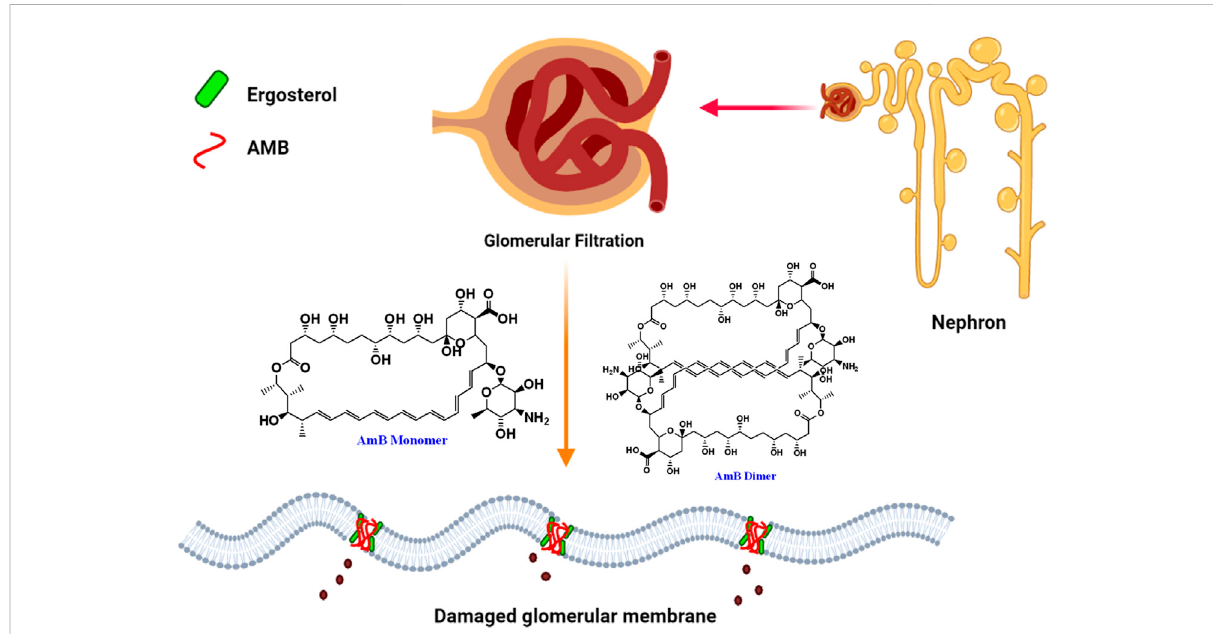
FIGURE 2 Pictorial presentation of AmB-mediated nephrotoxicity caused by ergosterol binding and depletion from glomerular membrane of nephron by dimeric insoluble form of